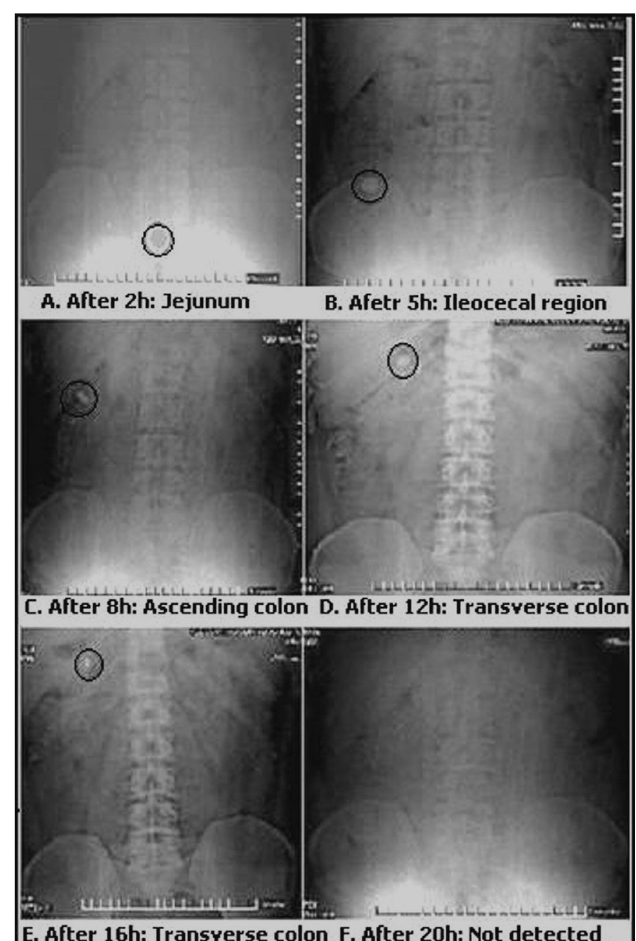
FIGURE 4 - The X-ray images at different time points showing tablet formulation CLH63 localization in the gastrointestinal